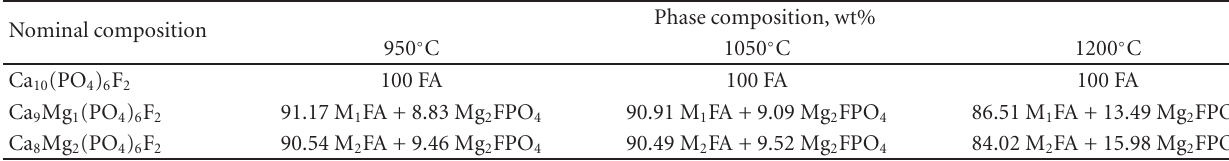
Table 3: Phase composition of sintered samples (XRD